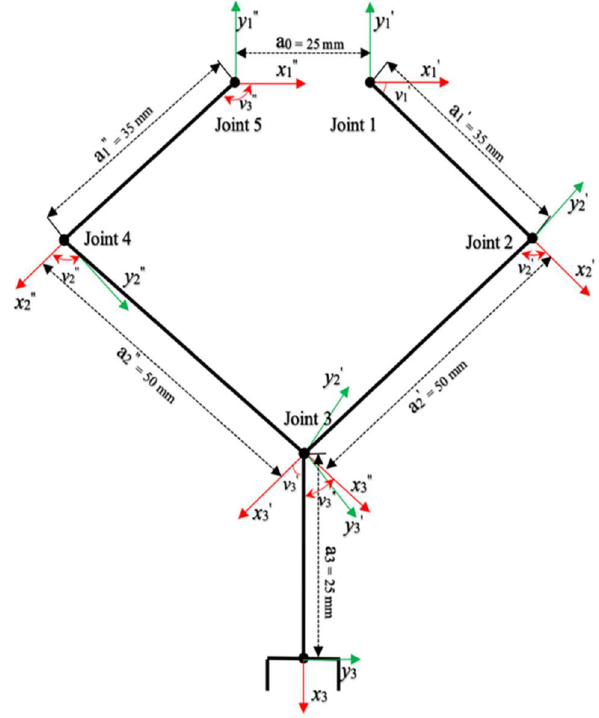
Figure 5. Modelling calibration of the MDH algorithm.